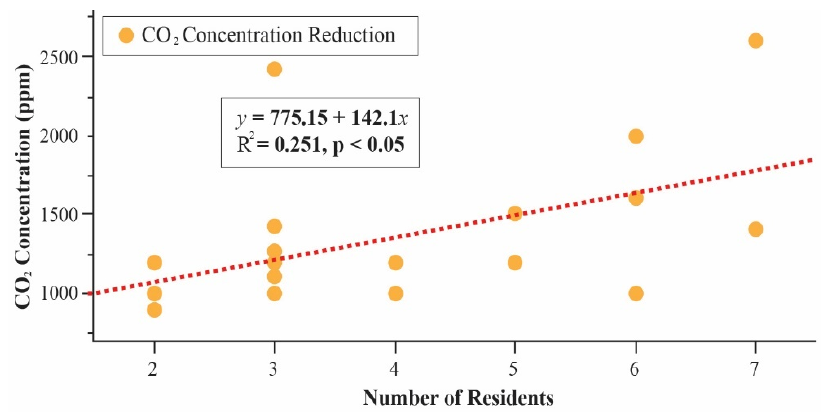
Figure 14. CO 2 concentration by number of residents.